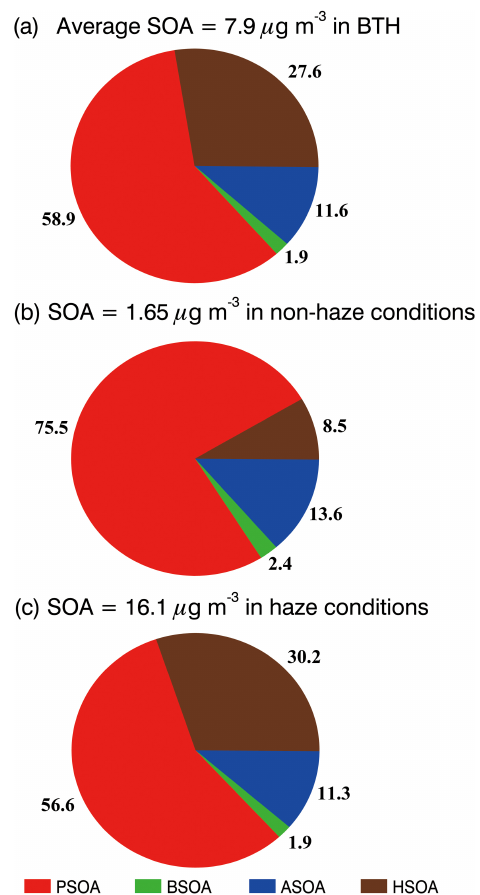
Figure 9. SOA contribution of different formation pathways over BTH (a) during the whole simulation period, (b) under non-haze conditions, and (c) under haze